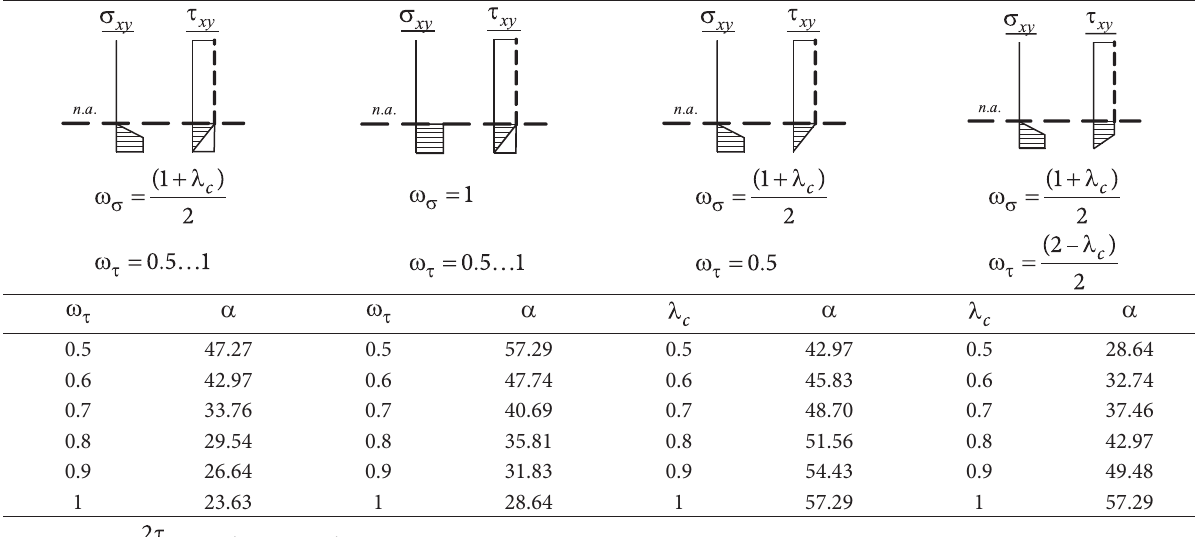
Table 1. Influence of stress diagrams on the angle of the principle stress trajectories